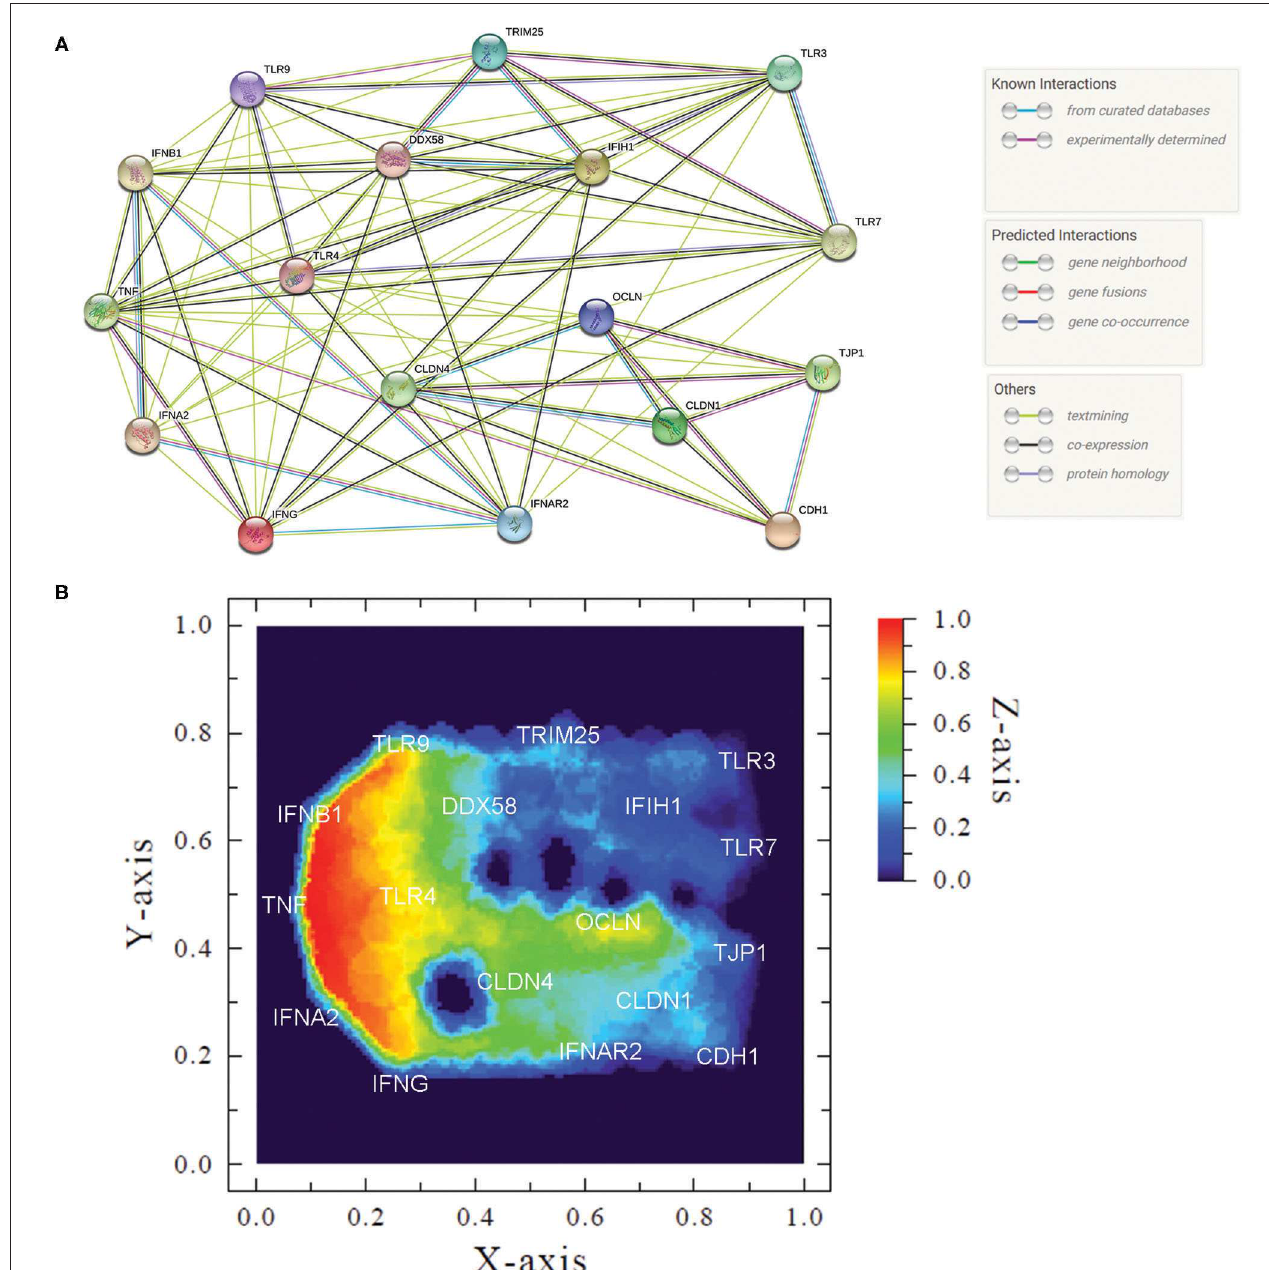
FIGURE 5 | Measured innate immune and adhesion gene expression patterns and gene interactions. (A) Protein network of analyzed genes showing action types and effects of proteins (created using string-db.org). (B) Heatmap of gene expression patterns comparing HPV- women with HPV + counterparts. We used median to calculate the “relative expression activity” ( n α ), except for TLR3, TLR7, E-caderin, Claudin-1, Occludin, and ZO-1, in that the HPV + group was zero and we used the mean. In this graph, coordinates (X- and Y-axis) represent normalized values of the input network topology. Color gradient (Z-axis) represents the n α value in the color scale. Red signal represents high expression and blue, low expression in HPV + compared with HPV-